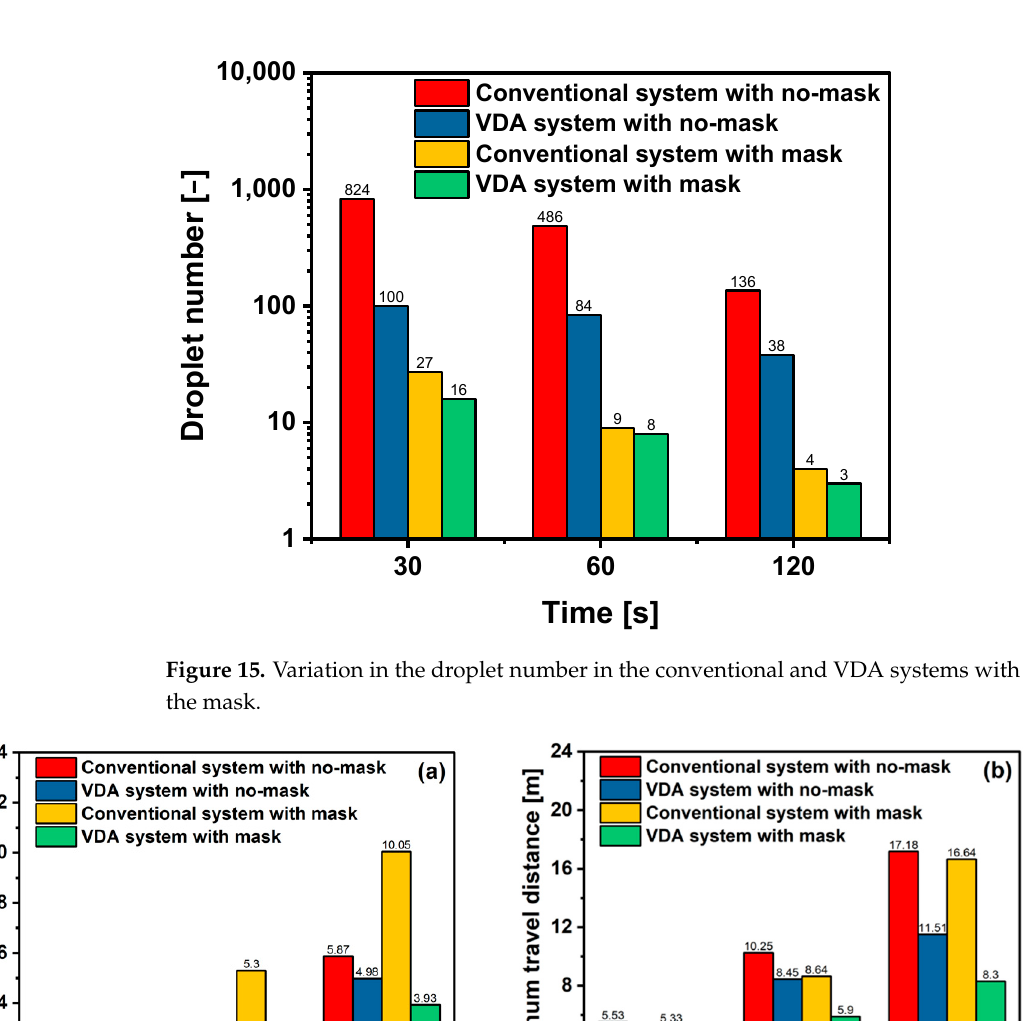
Figure 17. Proportion of droplets in the conventional and VDA systems with and without the mask 120 s after coughing.